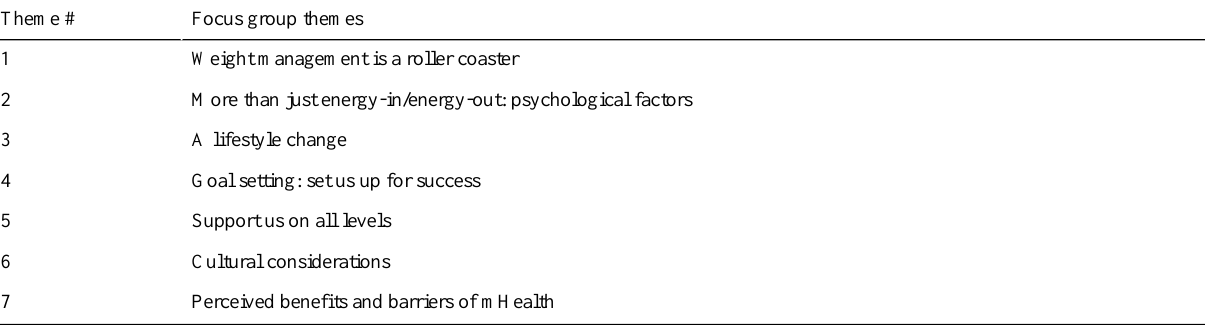
Table 1. Focus group themes.